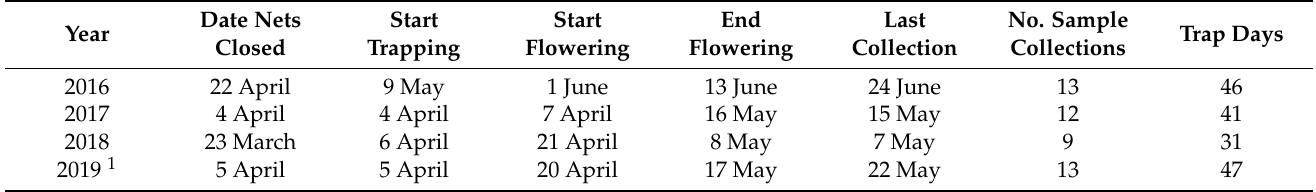
Table 1. Dates when hail nets were closed, traps were filled for the first time (start trapping), start and end of apple flowering, and last collection of sampled material. The number of sample collections (how often the traps were emptied), and the trapping days per year are also